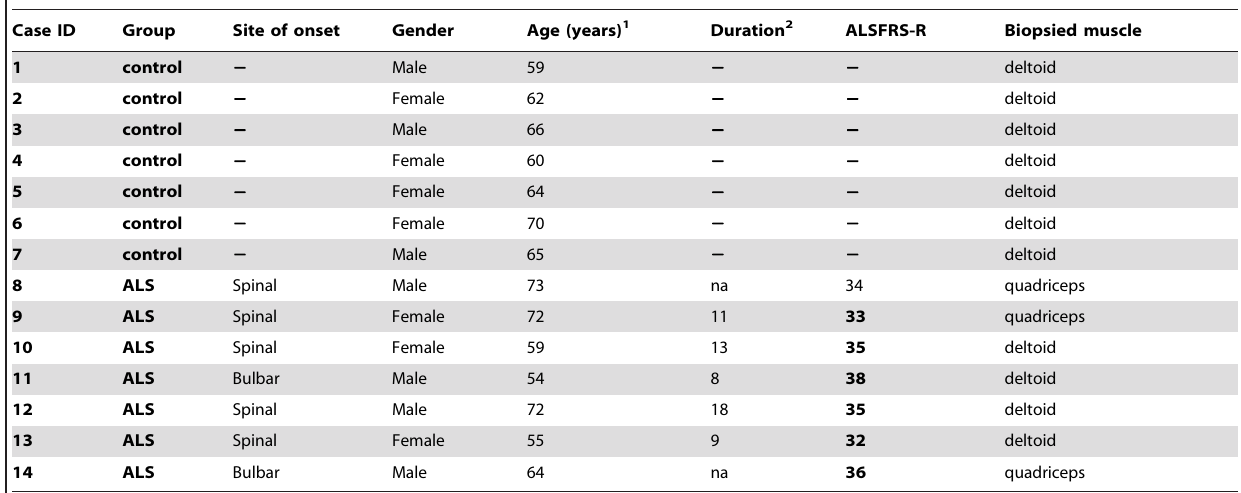
Table 1. Differentially expressed genes